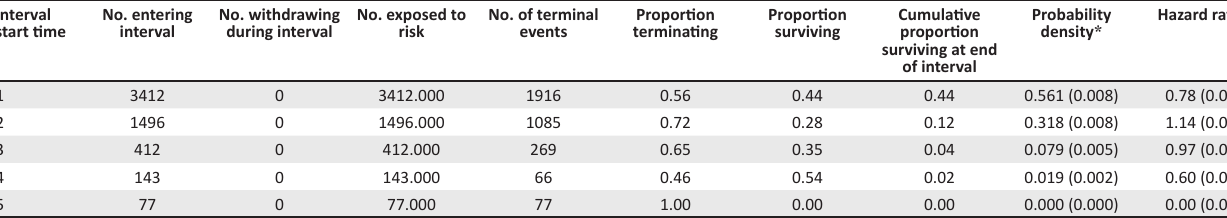
TABLE 6: Life table of overall results. Interval start